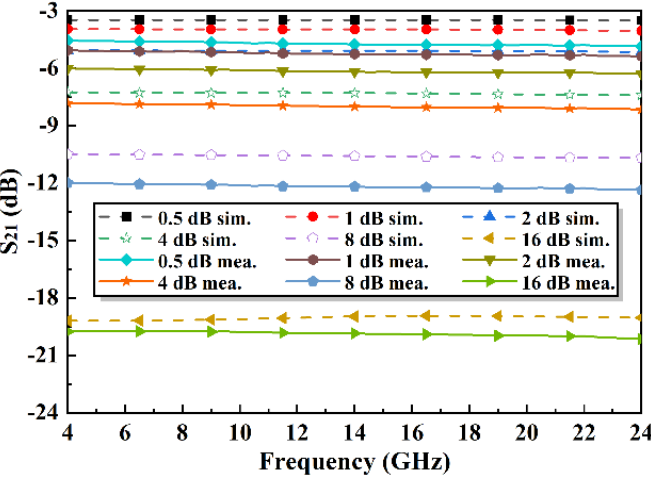
Figure 17. The simulated and measured attenuation results of the major states.